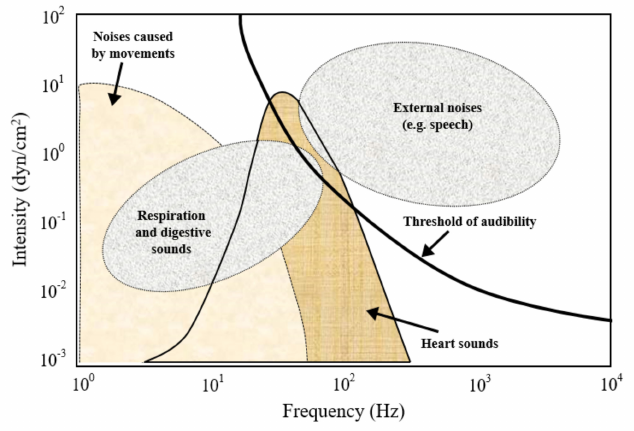
Figure 1. Spectral intensity map of phonocardiographic records